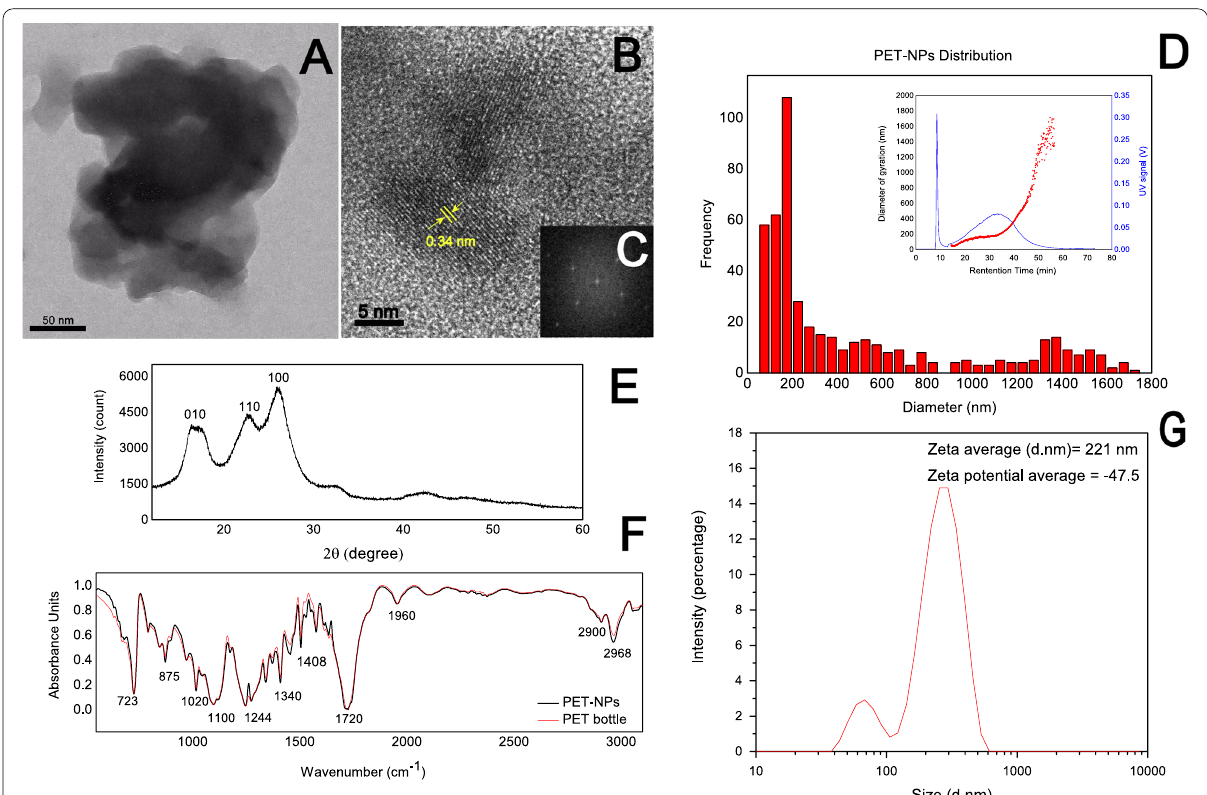
Fig. 1 PET NP‑s characterization. TEM images of PET‑NPs at different magnifications ( A , B ). Crystal planes ( B ) and its FFT ( C ). PET‑NPs size distribution obtained after precipitation by A4F analysis ( D ). The XRD spectra ( E ), FTIR spectra ( F ) and the size distribution of nanoparticles after settling, used for cell experiments ( G